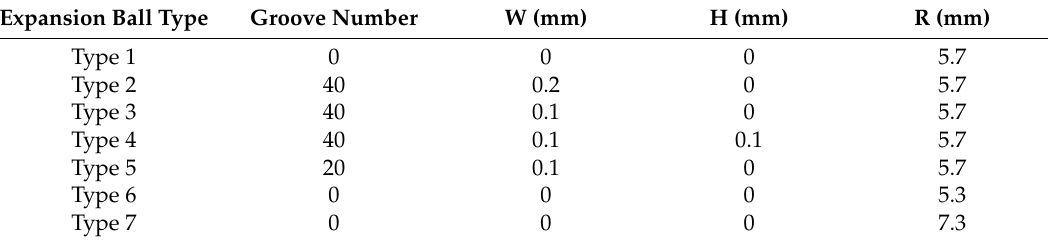
Table 2. Design variables for different expansion ball shapes.